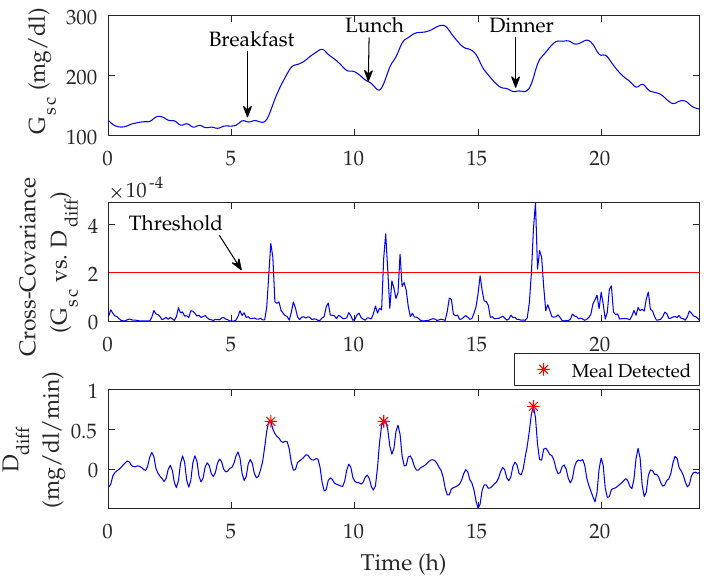
Figure 3. Illustration of the meal detection algorithm showing subcutaneous glucose ( G sc ) values from a continuous glucose monitor values (top graph), cross-covariance (middle graph) and the forward difference of the disturbance parameter, D dif f (bottom